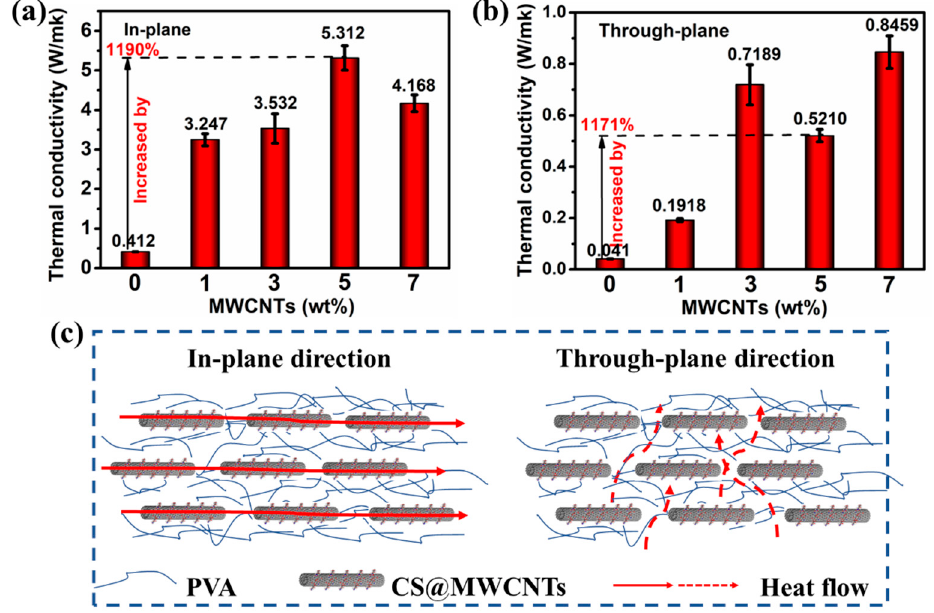
Figure 7. In-plane ( a ) and through-plane ( b ) thermal conductivity ( ĸ ) of pure PVA and PVA/CS@MWCNTs composite films varied with the loading of MWCNTs; ( c ) Schematic diagram of thermal conductivity of PVA/CS@MWCNTs composite films.